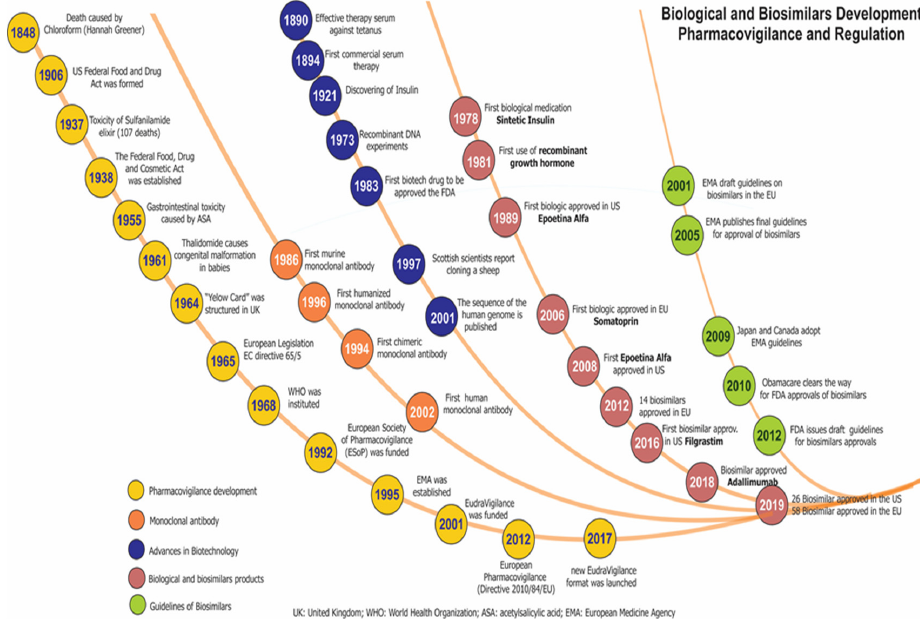
Figure 3. Timeline of pharmacovigilance and regulation of biopharmaceuticals and biosimilars.